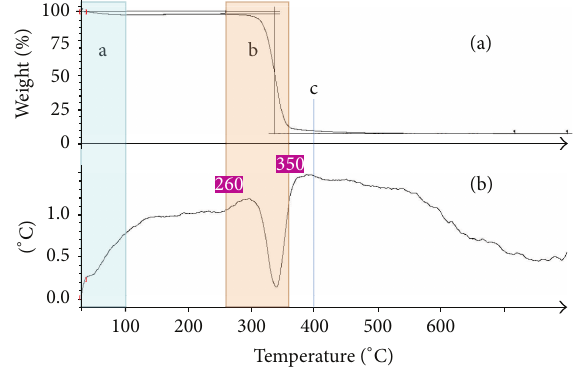
Figure 3: TG and DTA curves of the cellulose particles.